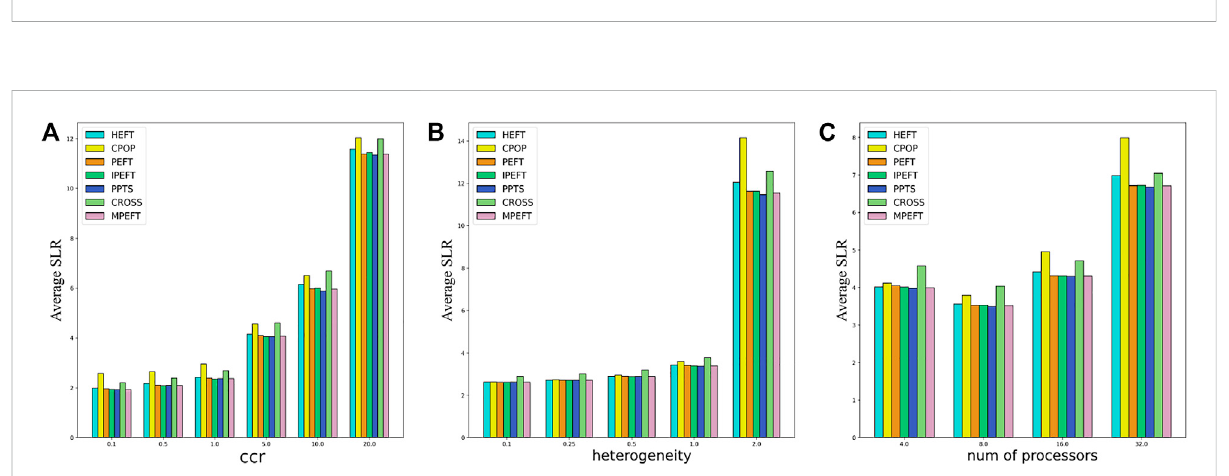
FIGURE 11 Average SLR as function of ccr (A) , heterogeneity (B) and number of processors (C) for Montage Work fl ows.